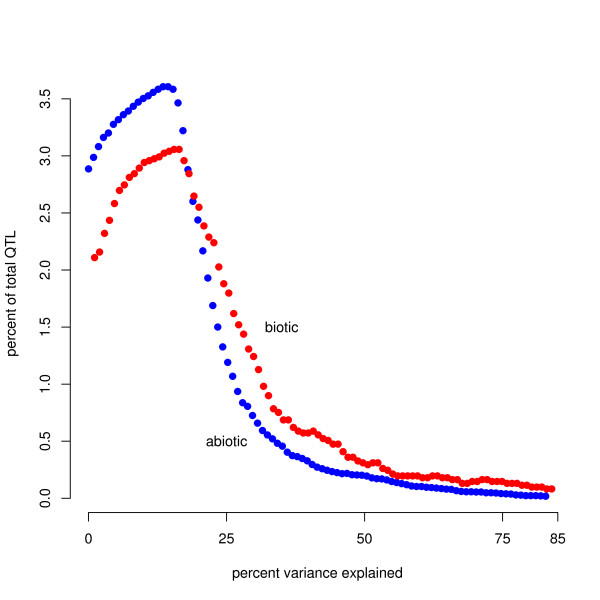
Probability distribution derived via applying a moving average to the data of QTL effect size (PVE) of abiotic and biotic traits (see methods). The figure includes data from all accessions (N = 229 for biotic, 1721 for abiotic).